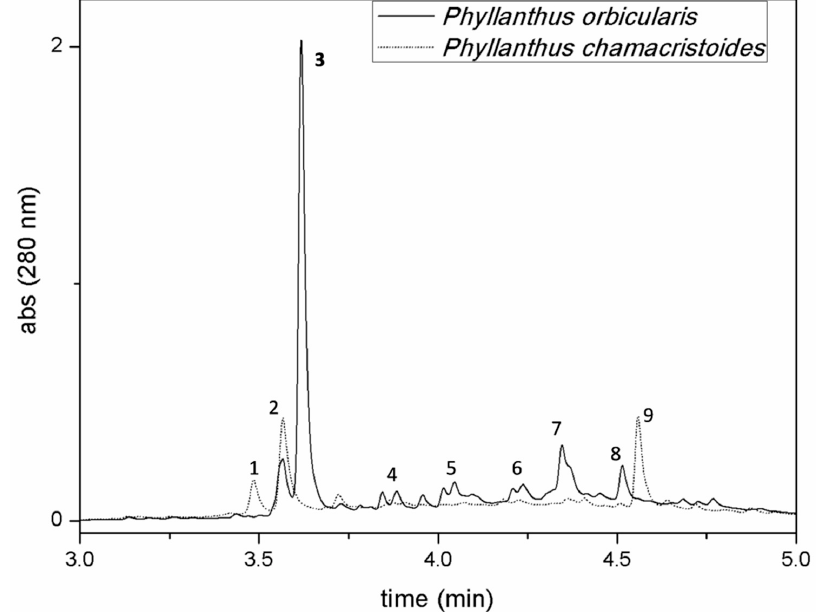
Figure 1. UPLC-DAD (280 nm) chromatograms of Phyllanthus orbicularis and Phyllanthus chamacristoides aqueous extracts and assignments of eluting